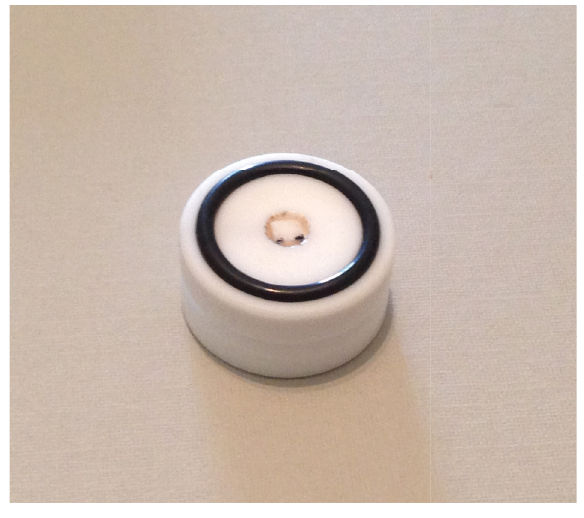
Figure 1. Acrylic apparatus where the dental enamel block was placed at the center.